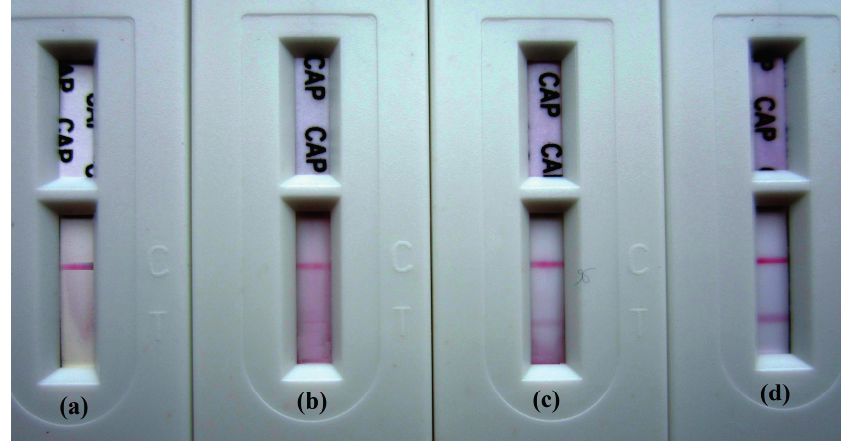
Figure 8. The assay results of crucian carp muscles injected with CAP at dose of 5, 3, 1 and 0 µg/kg.bw respectively, from left to right.